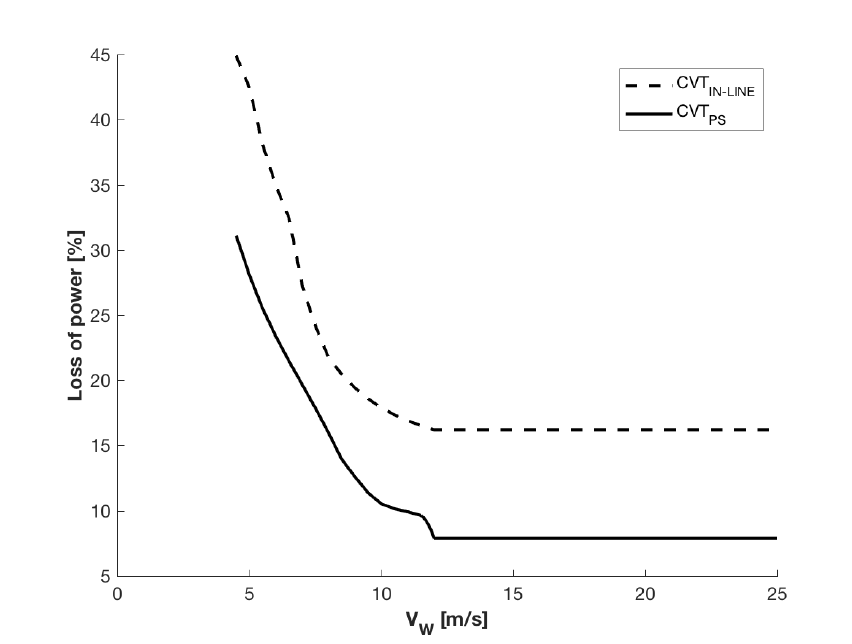
Figure 8. Loss of power for the two architectures.